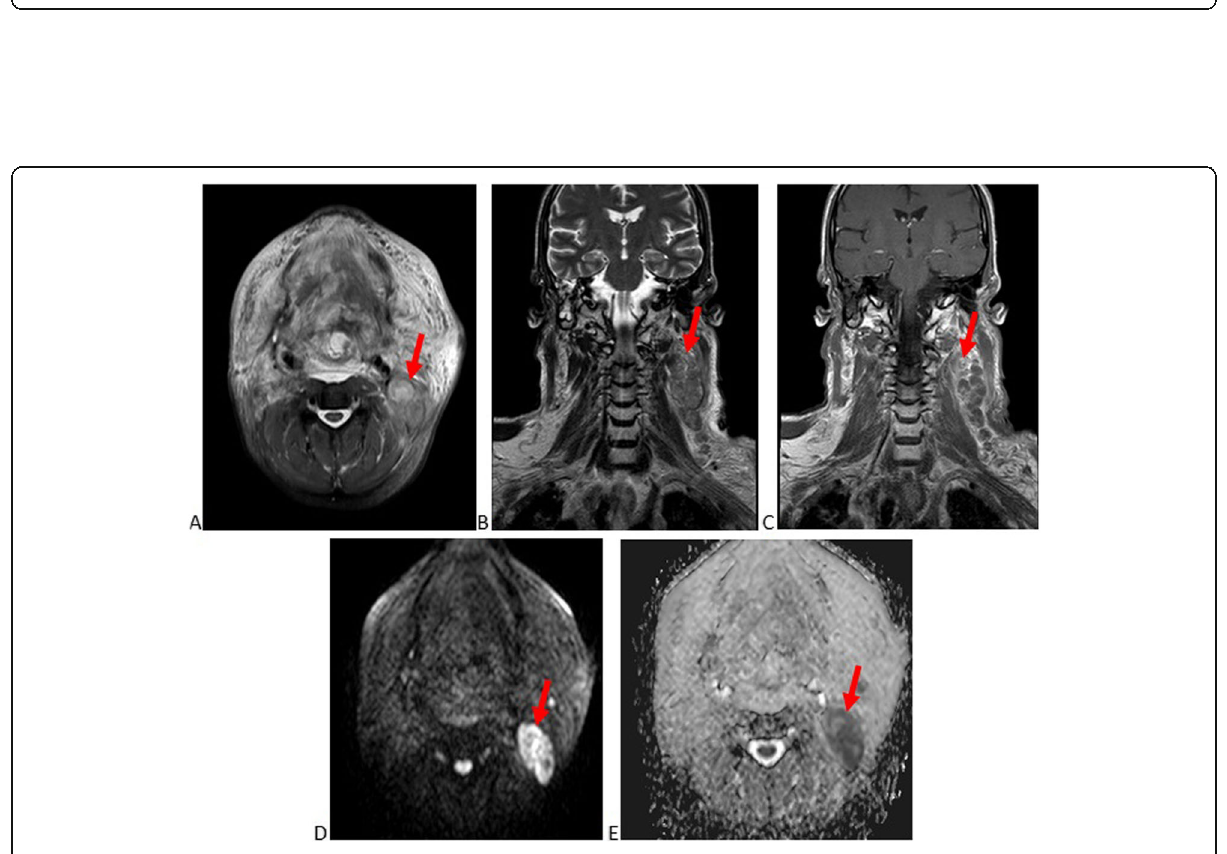
Fig. 6 Fifty-five -year-old male with a known history of laryngeal carcinoma a axial T2, b coronal T2 WIs showing multiple enlarged left deep cervical and supraclavicular lymph nodes exhibiting intermediate to high T2 signal. c Post-contrast coronal T1 WIs showing heterogeneous contrast uptake and breaking down . d DWIs b 1000 and e ADC map showing hyperintense LNs in diffusion images corresponding to low signal in ADC map with an ADC value varying from 0.893 × 10 − 3 to 0.927 × 10 − 3 mm 2 /s; the possibility of metastatic nodal deposits is considered which was proven by